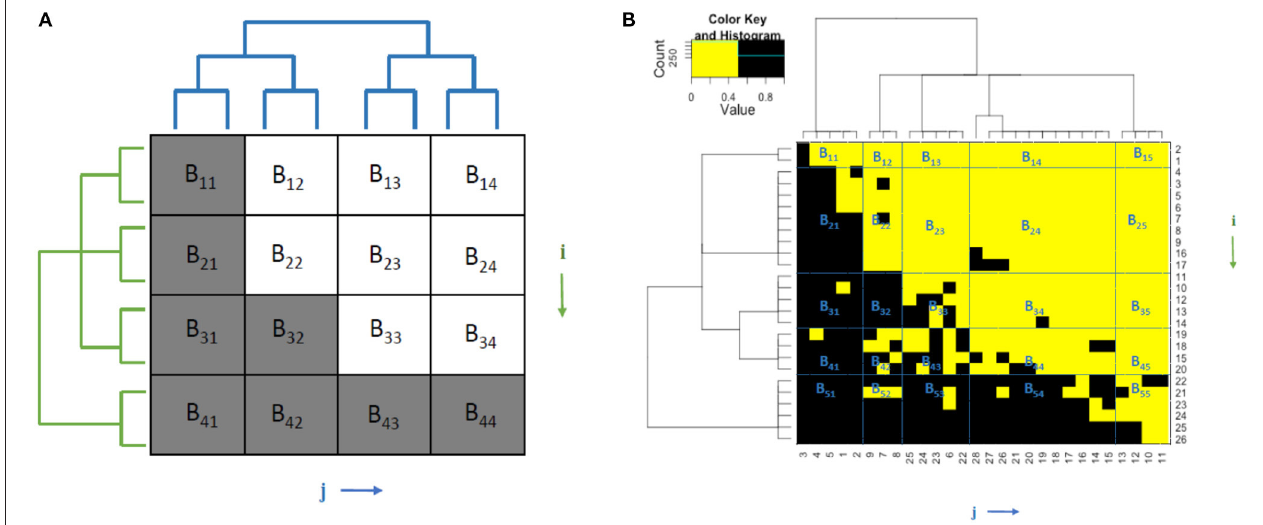
FIGURE 1 | (A) Illustration of theoretical multiscale block structures and coupling geometry of a perfectly nested bipartite network. Interactions are marked in gray while noninteractions are in white. (B) The multiscale block structures and coupling geometry of a mammalian dataset that contains 26 mammalian species in 28 mountain ranges [10]. Interactions are in black and non-interactions are in yellow.